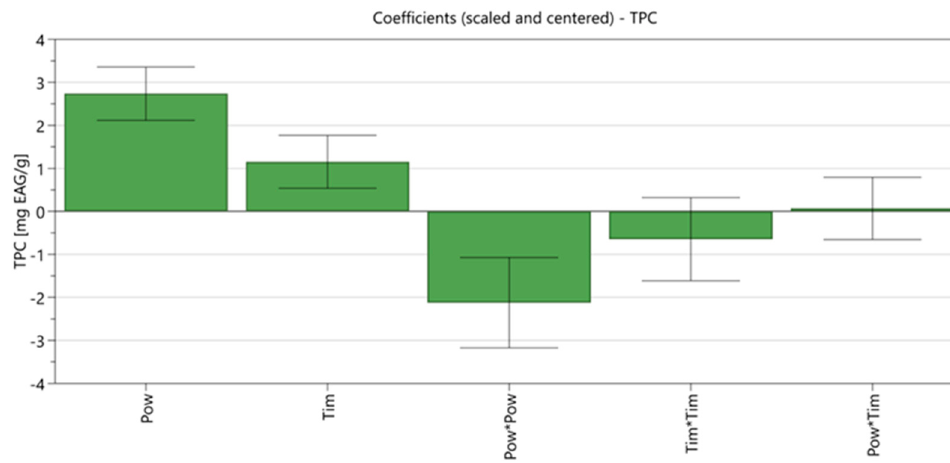
Figure 1. Summary of fit for DoE model.